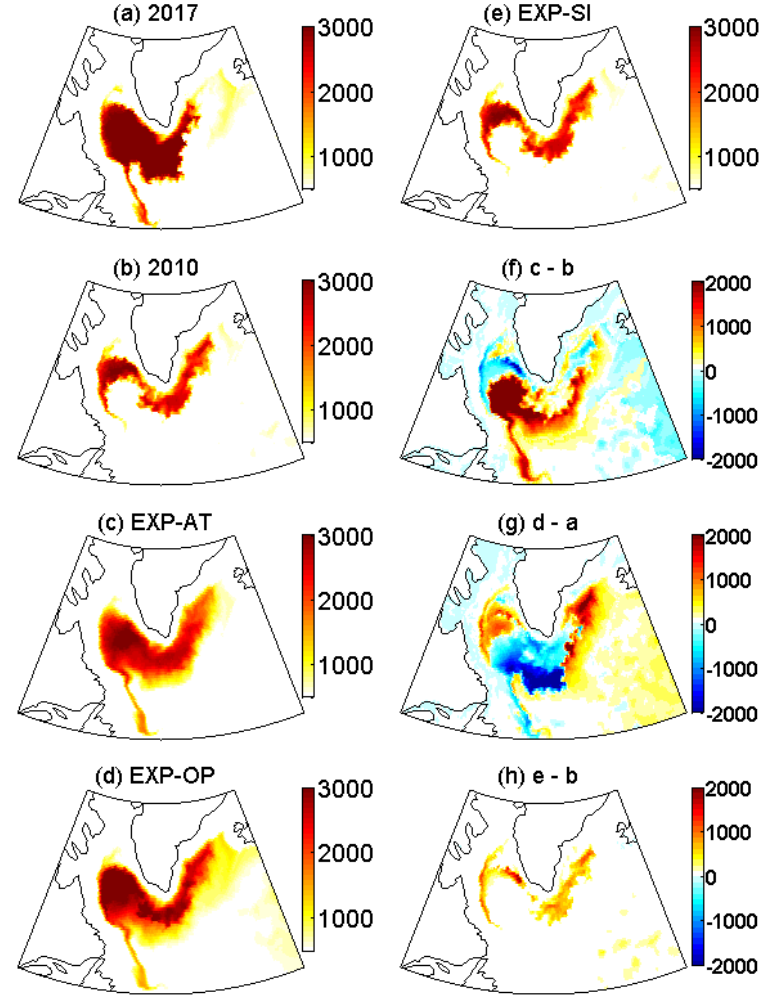
Figure 4. The distributions of March MLD of 2017 ( a ) and 2010 ( b ) in CTRL; and the ensemble mean of the March MLD in EXP−AT ( c ), EXP−OP ( d ), and EXP−SI ( e ); and the differences between the CTRL and ensemble mean experiments: c minus b ( f ), d minus a ( g ), and e minus b ( h ).